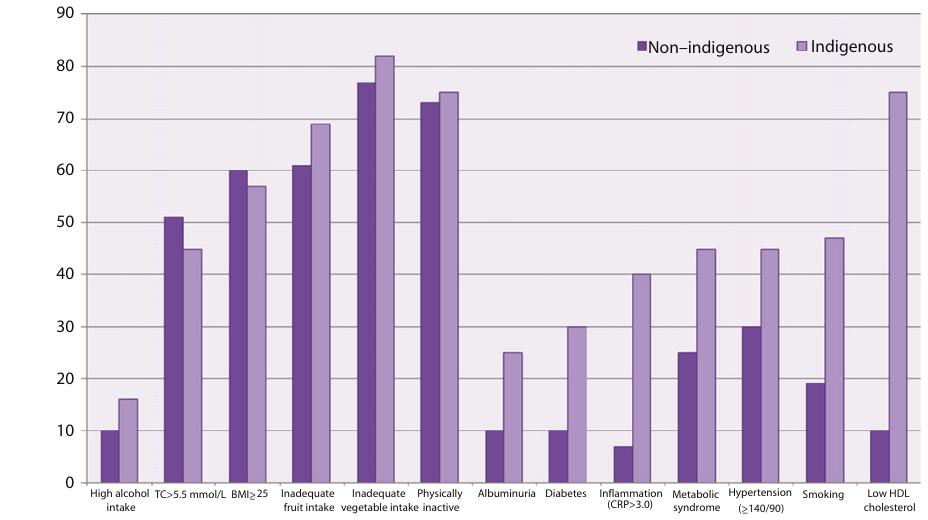
Figure 6. Risk factor differentials between indigenous and non-indigenous Australians [3,8,12,17,47–51].